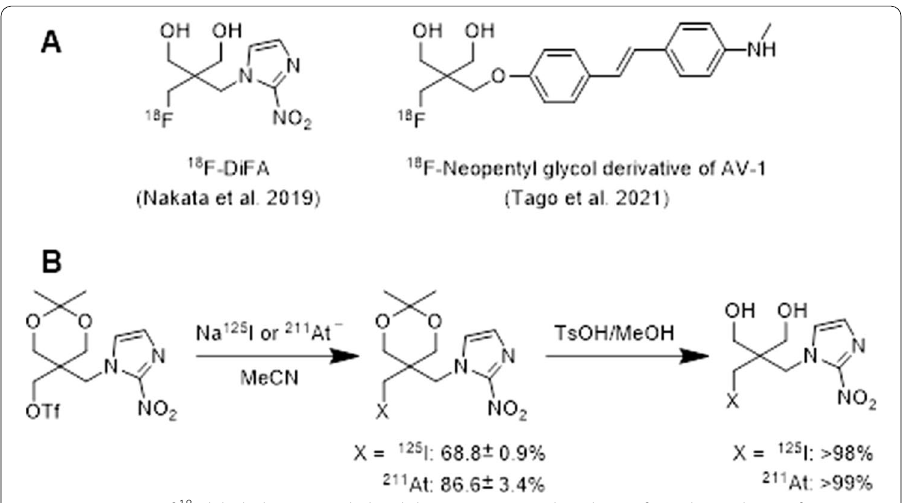
Fig. 1 Structures of 18 F‑labeled neopentyl glycol derivatives ( A ) and a scheme for radiosynthesis of 125 I/ 211 At‑labeled neopentyl glycol derivatives ( B